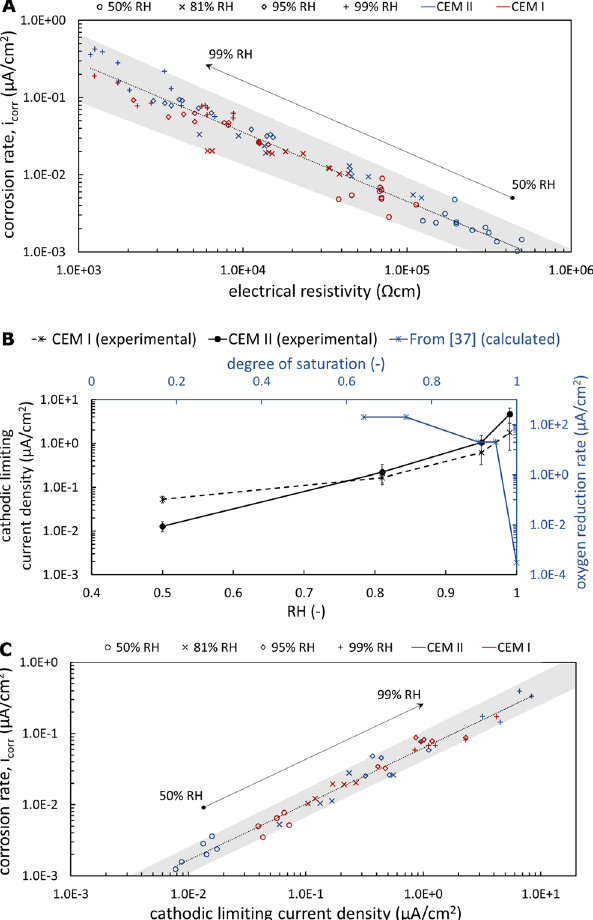
Figure 2. Correlation between corrosion rate ( i corr ) and other electrochemical parameters as well as illustration of the oxygen paradox in dense porous media. ( A ) Traditional representation of i corr vs. electrical resistivity of concrete that may erroneously be interpreted as proof for a causality; ( B ) The cathodic limiting current density has been experimentally measured as increasing with RH (black series: symbols = mean values, whiskers = standard deviations). On the contrary, in the literature, oxygen has always been considered as decreasing with RH, because of argumentations only based on the purely physical diffusion behaviour. An example taken from the literature 37 is reported in the figure, in order to show the completely opposite trend between what has been measured (black series) and what has been calculated in 37 (blue series); ( C ) Close correlation between i corr and i lim . Such correlation has never been shown before and it suggests there is the same mechanism controlling the two electrochemical